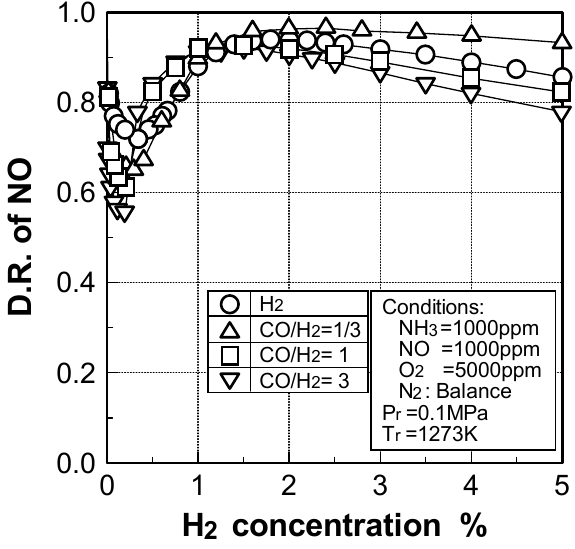
Figure 39. Relationship between decomposition ratio of NO and H combustible components as defined by experiments: same as Figure 38 except that the range of x-axis is within